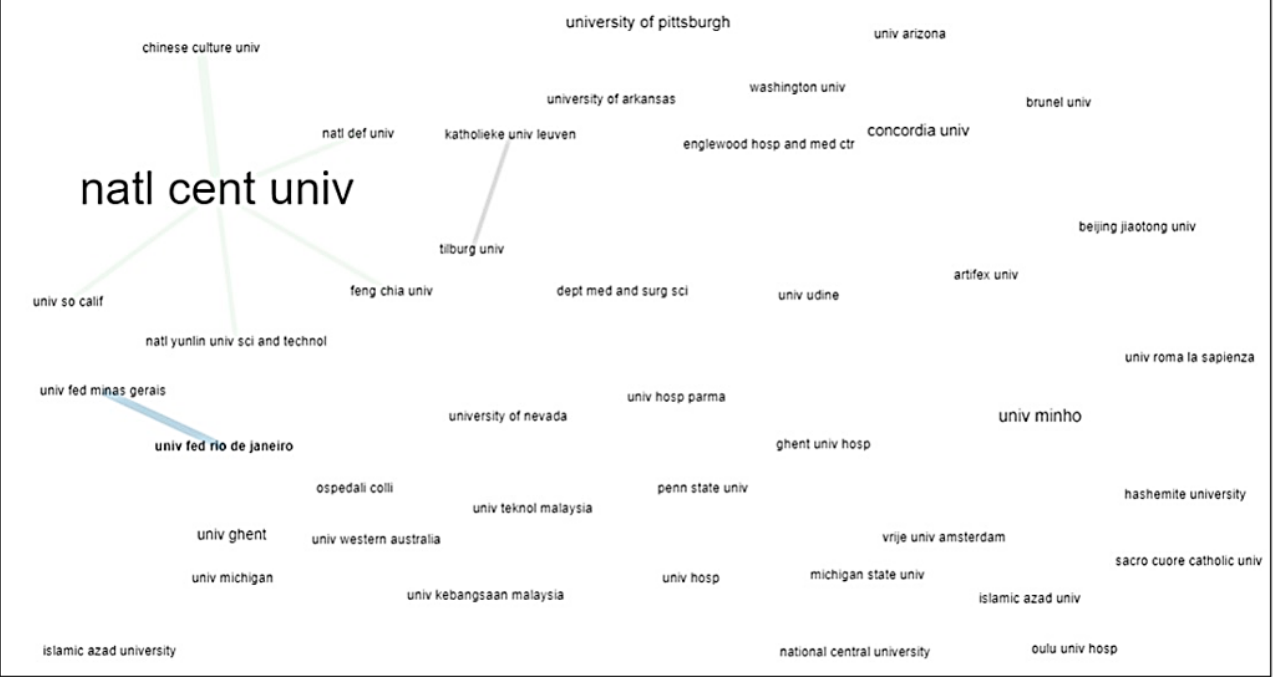
Figure 5. Collaborative networks between institutions.